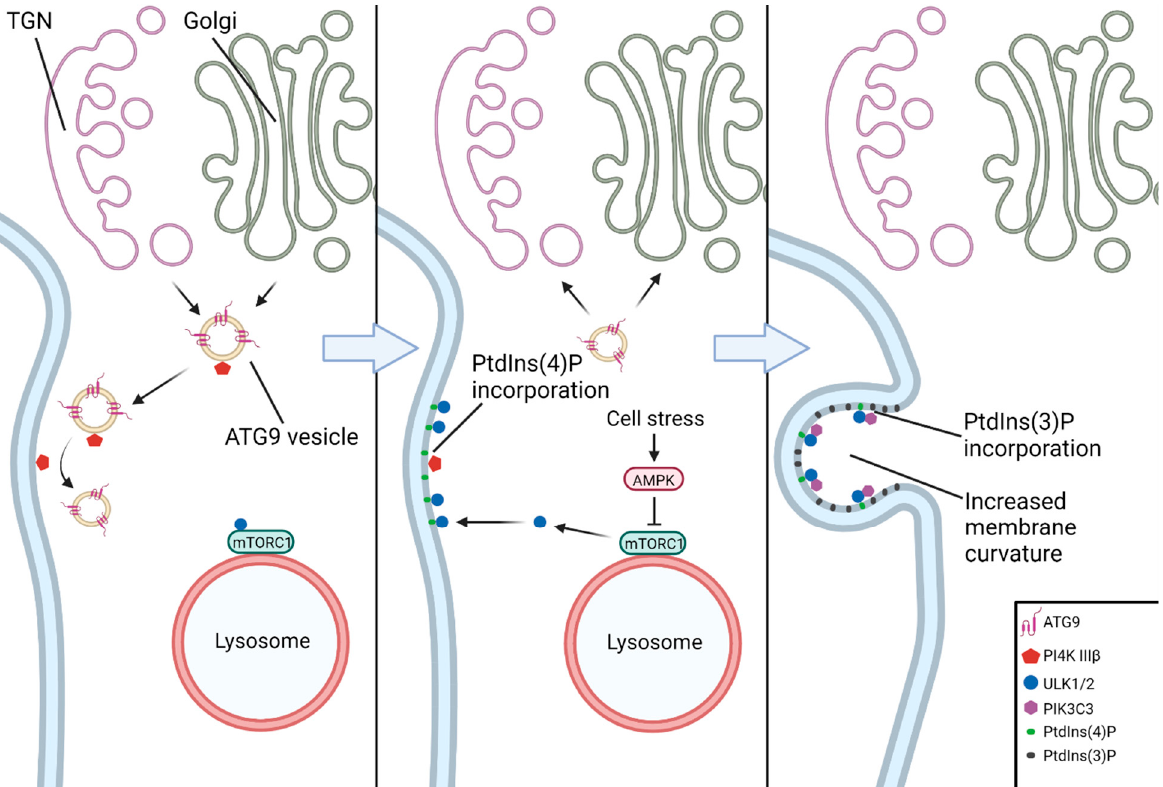
Figure 4. A model of formation of the omegasome. ATG9 vesicles carry PI4K III β from the Golgi and trans-Golgi network to the omegasome formation site. PI4K III β enriches the ER membrane in PtdIns(4)P, which binds ULK1/2 after its AMPK-mediated release from mTORC1 at the lysosomal surface. ULK1/2 subsequently recruits PIKC3C, which enriches the ER membrane in PtdIns(3)P, resulting in increased membrane curvature. As more PtdIns(3)P is incorporated, the highly curved membrane forms the omegasome, where the phagophore may be nucleated.